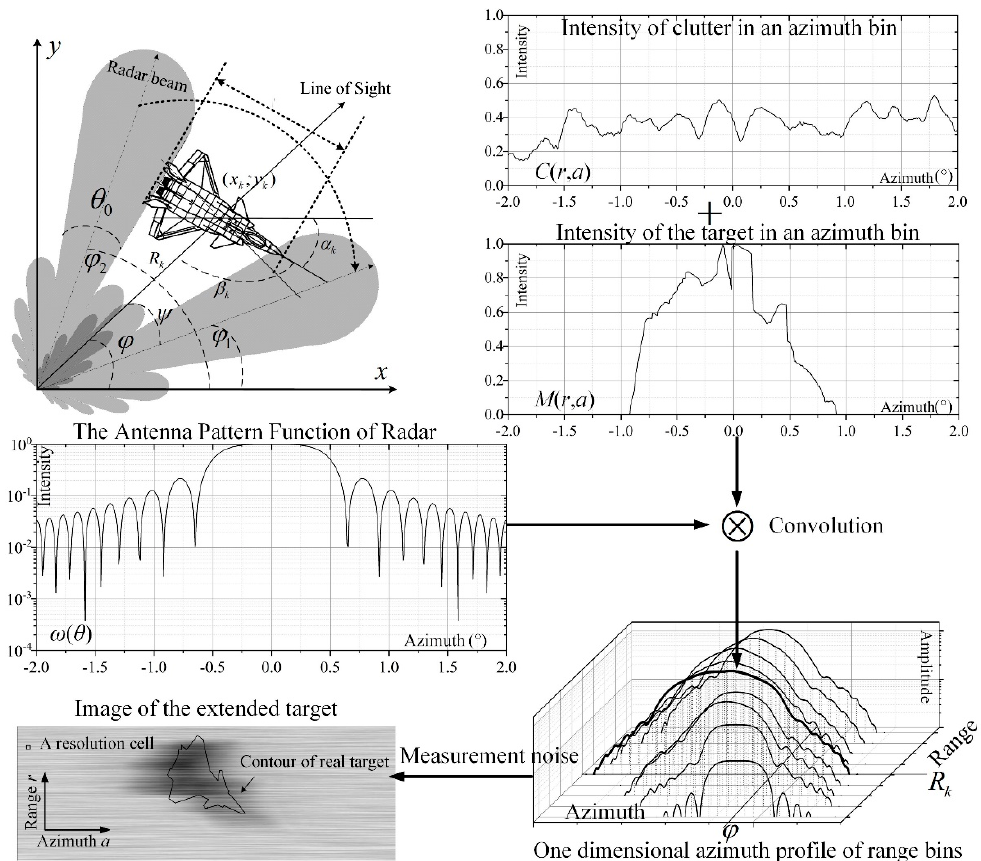
Figure 2. The measurement model of marine radars.